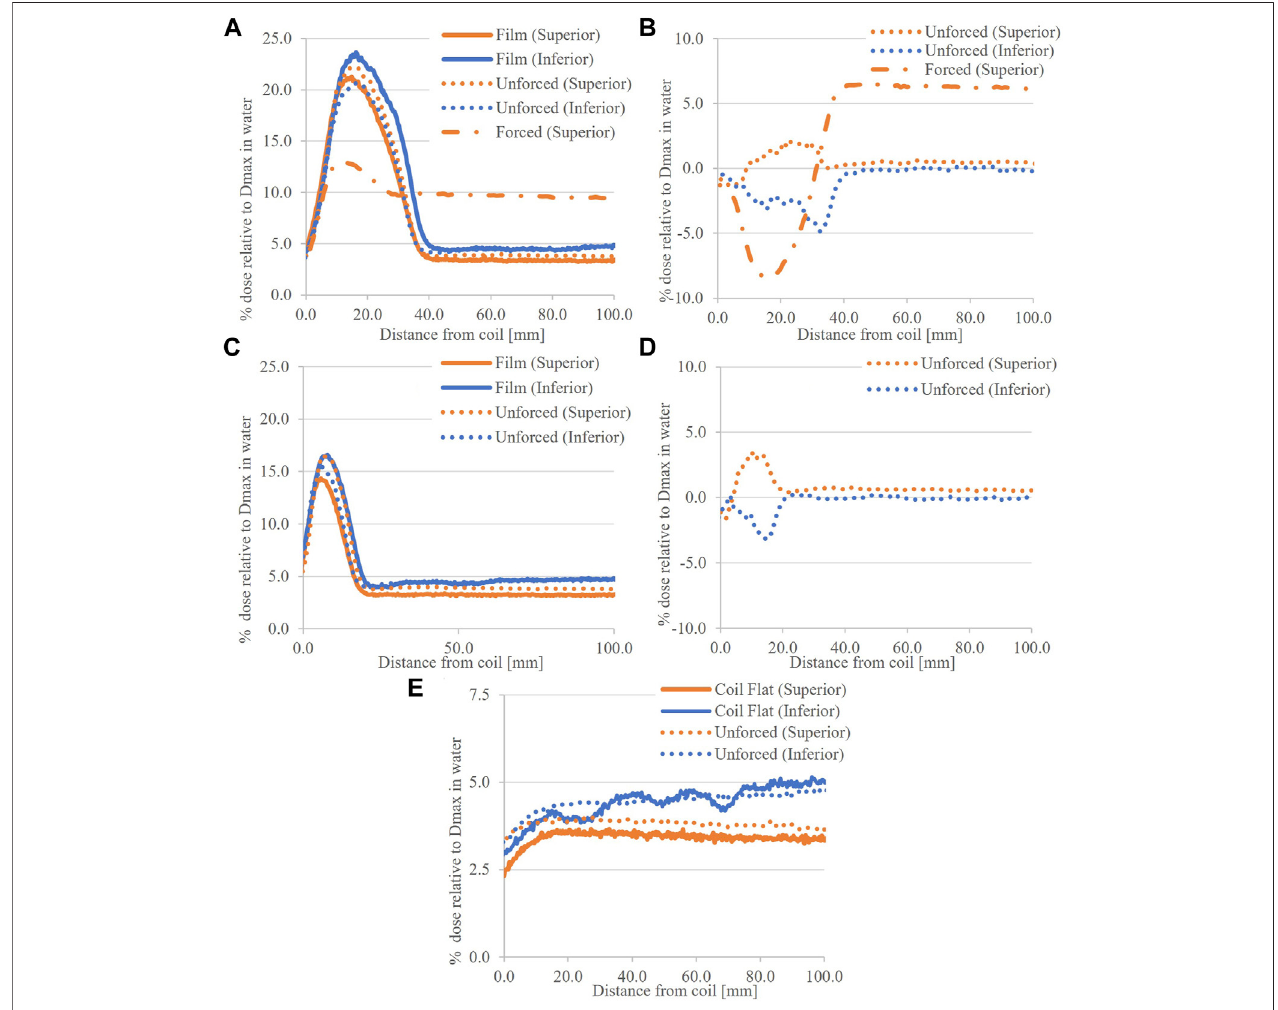
FIGURE8| Calculated and measured ESE dosefor the5.0 ×22.0 cm 2 fi eld withthe Elekta coil model. (A) showsthe 7.0 ° tilt data,with (B) associateddifferences, and in (C) , the 3.5 ° tilt data and (D) differences. In (E) , the coil fl at data isgiven with differences omitted given the consistency of measured data with tail regions from the tilted